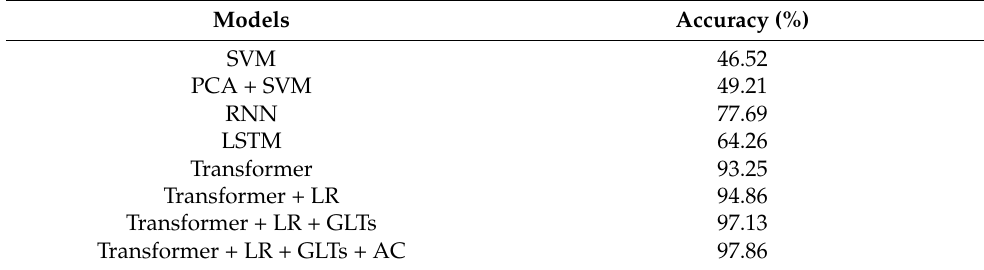
Table 2. Recognition performance of six different models.